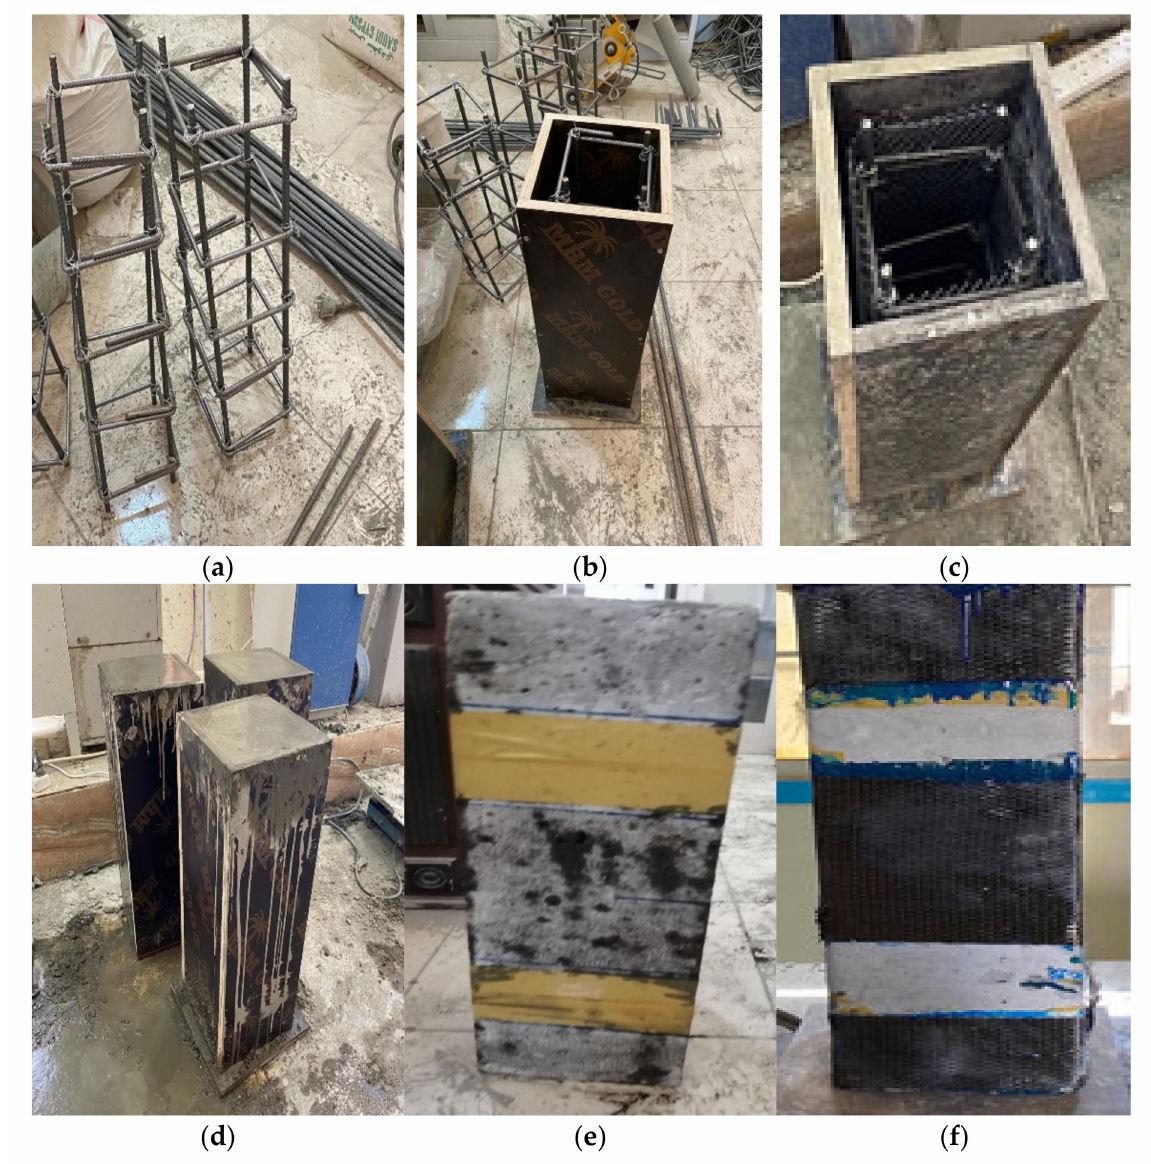
Figure 4. Procedures for column preparation. ( a ) Reinforcement details, ( b ) mold preparation, ( c ) welded mesh application, ( d ) casting, ( e ) surface preparation, and ( f ) CFRP application. The columns were divided into eight groups depending on the testing variables (Table 4). The concrete type (normal and rubberized concrete), strengthening method (EB CFRP strengthening and internal WWM), strengthening configuration (partial and full EB strengthening), strengthening area (one layer and two layers), and the RSF content (2% RSF) were the considered tested variables. Three columns were prepared from the normal concrete mix (Mix0) (group 1). In this group, one un-strengthened column (Cc) was tested as a control column (Figure 5a), and one column was partially strengthened with one layer of the EB CFRP laminate (Figure 5b) to study the effect of the EB CFRP strengthening on the behavior of the columns. Moreover, the third column was partially strengthened with two layers of the EB CFRP laminates (Figure 5b) to study the effect of the strengthening area on the columns’